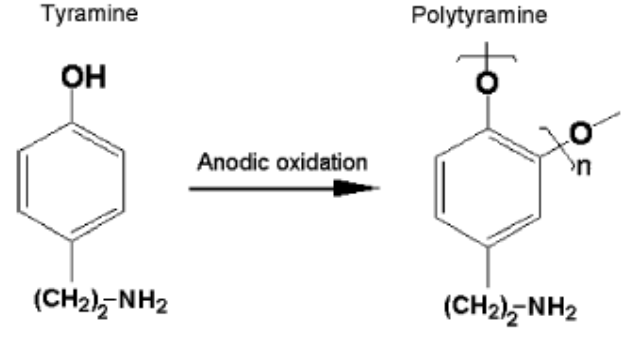
Figure 1. Polymerisation process of tyramine. Reproduced from